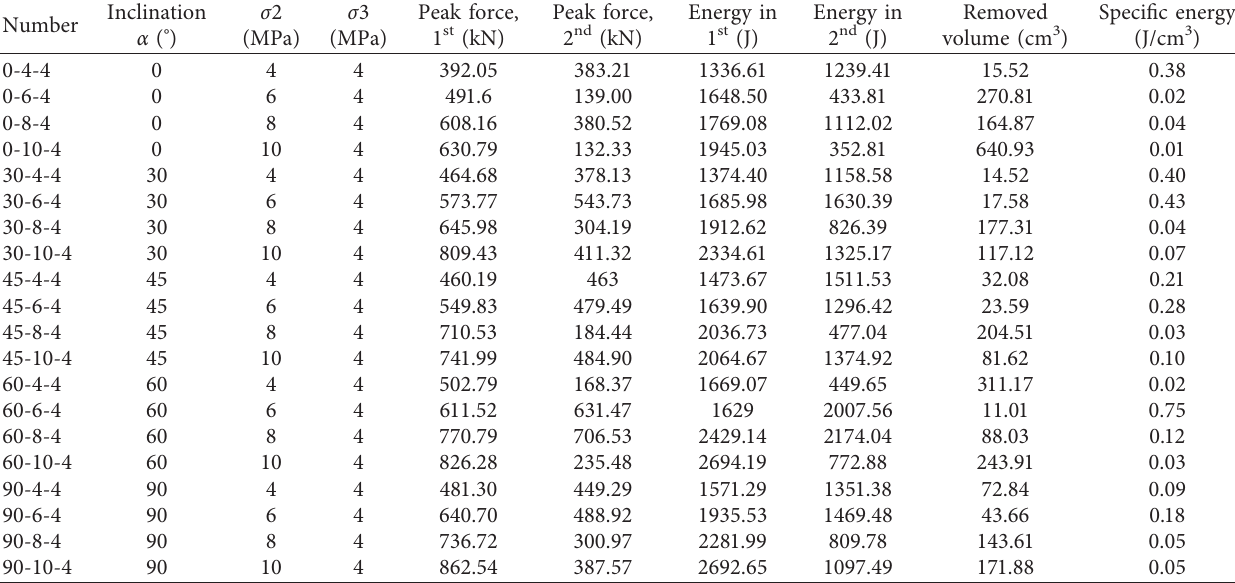
Table 1: The peak force, removed volume, and specific energy for all the tested layered